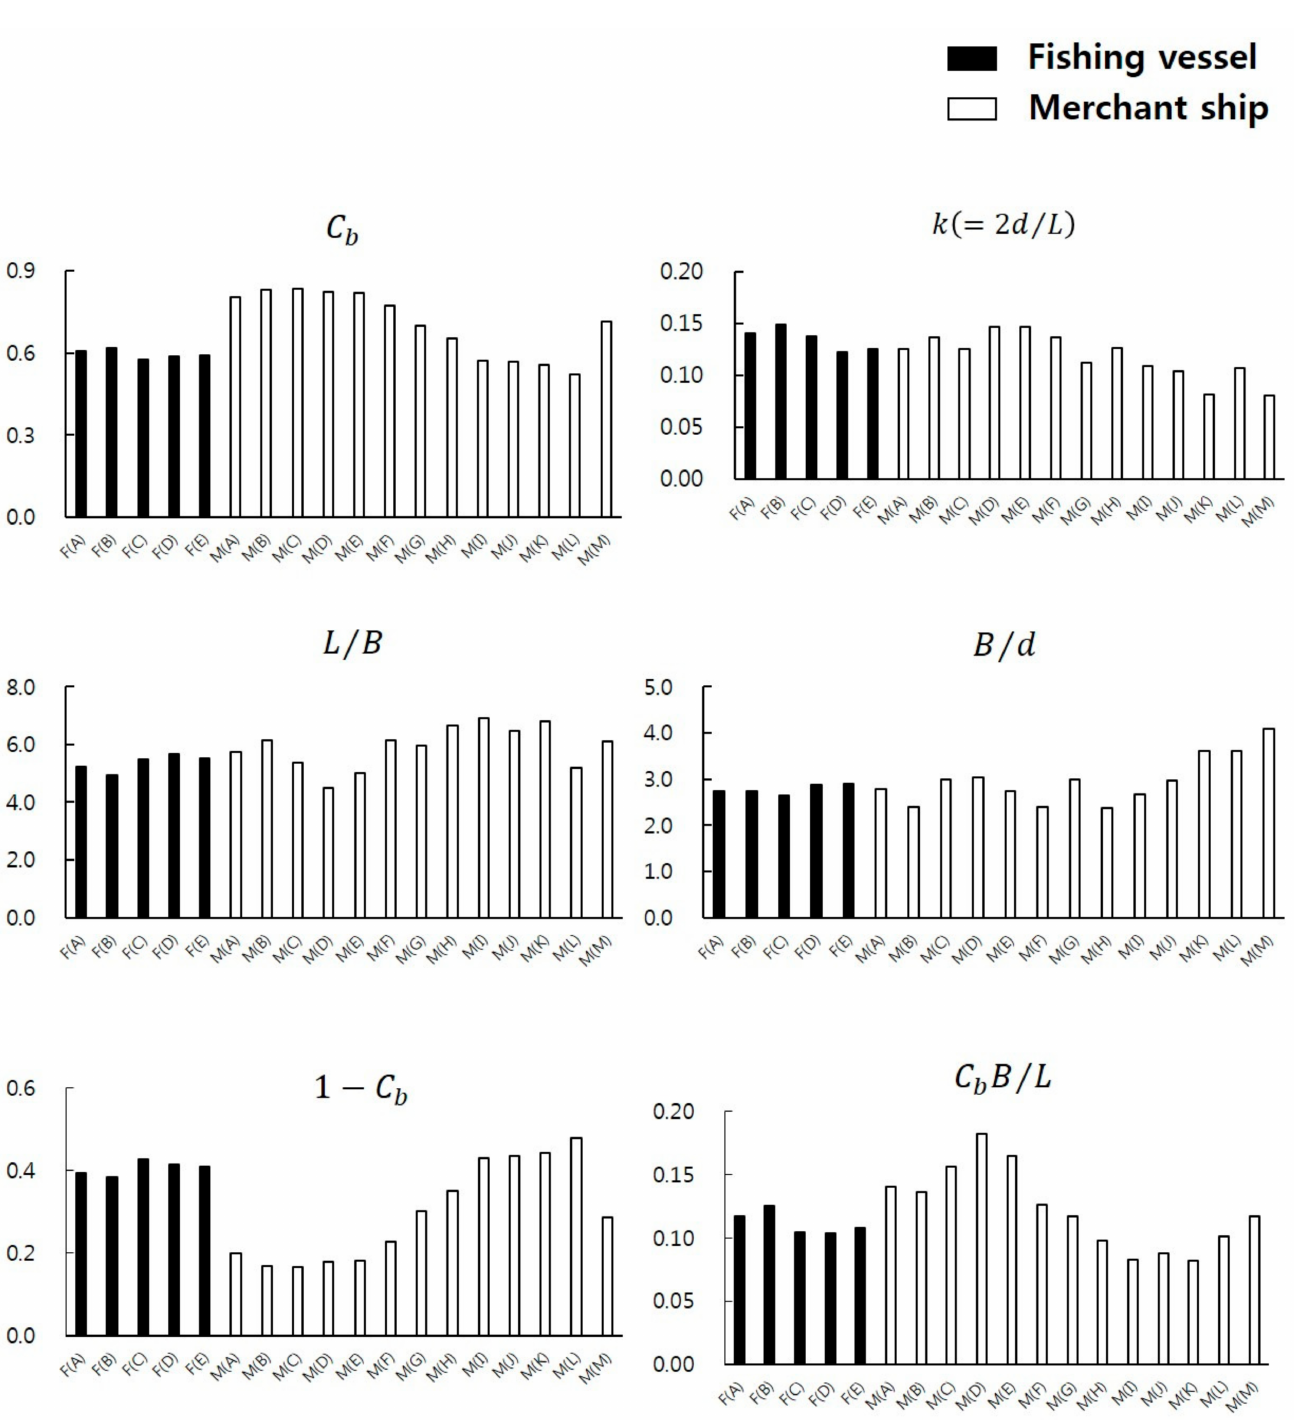
Figure 2. Hull shape parameters of 18